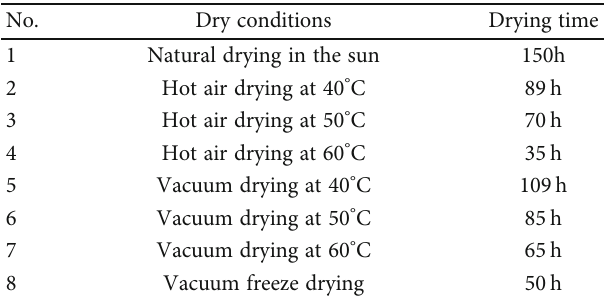
Table 1: Schisandra chinensis fruits samples of di ff erent drying